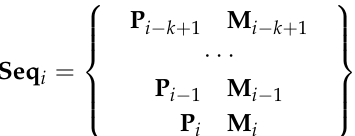
Figure 4. The designed trajectories for building a magnetic field map.